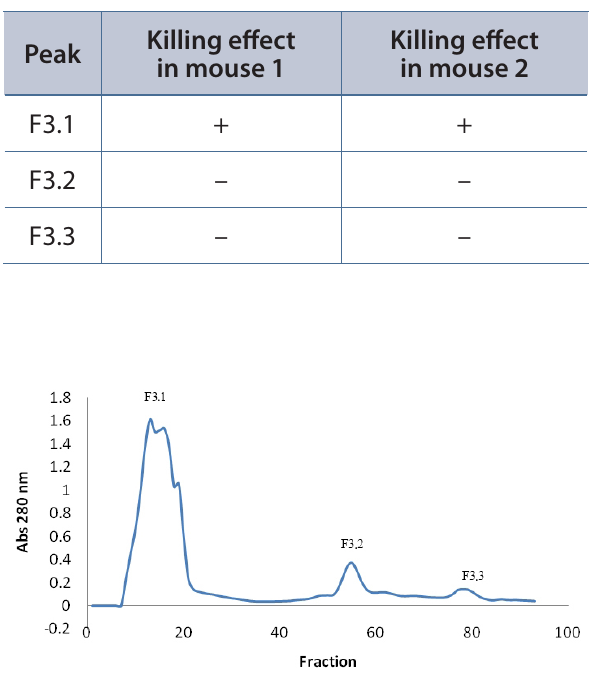
Table 2. Killing effect of F3 fraction obtained by